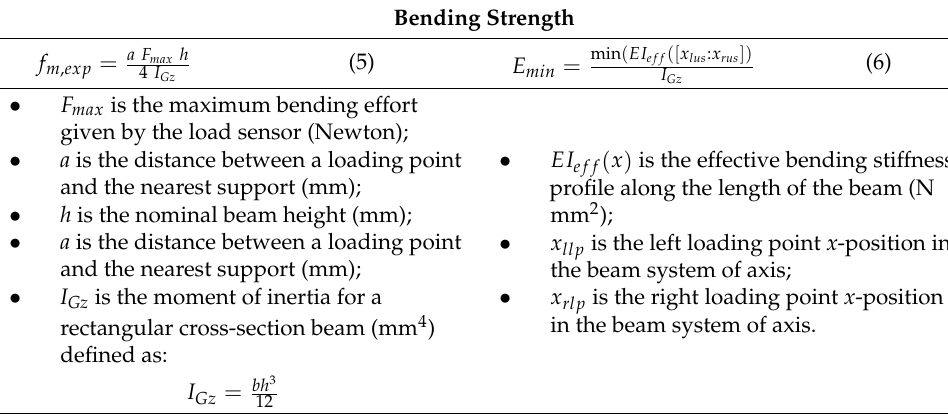
Table 5. Bending strength indicating